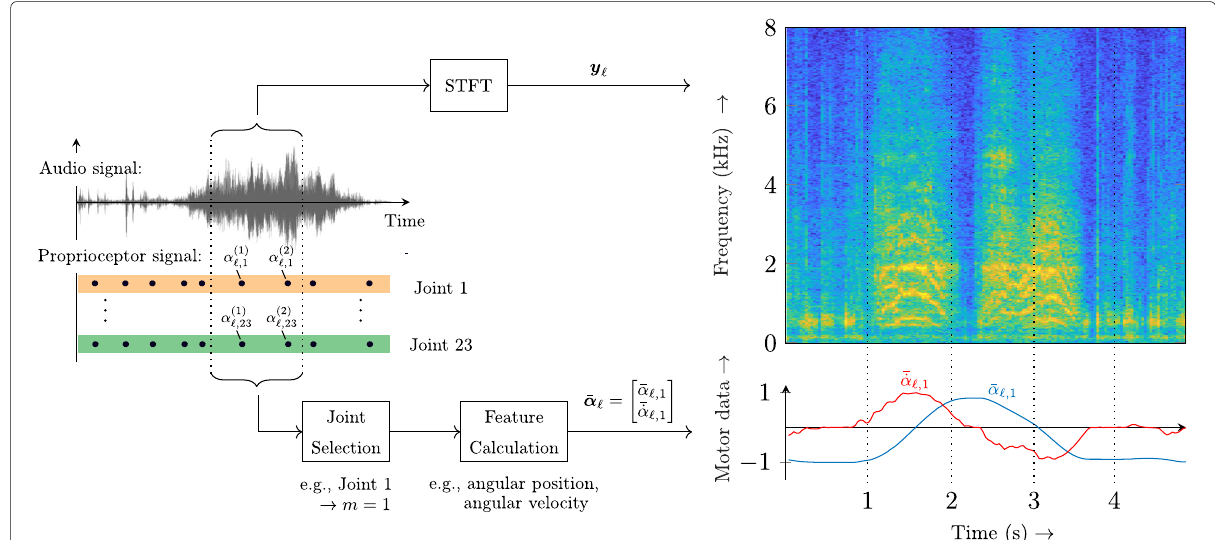
Fig. 2 Left: Illustration of data collection and processing. We consider a robot for which motor data of 23 joints and a single-channel microphone signal are recorded. The (cid:2) th STFT frame is processed. Note that the total number of motor data samples can be varying from frame to frame, c.f., Section 2.1. Right: Example spectrogram for right arm shoulder ego-noise and corresponding normalized motor data samples (angular position and angular velocity) of this